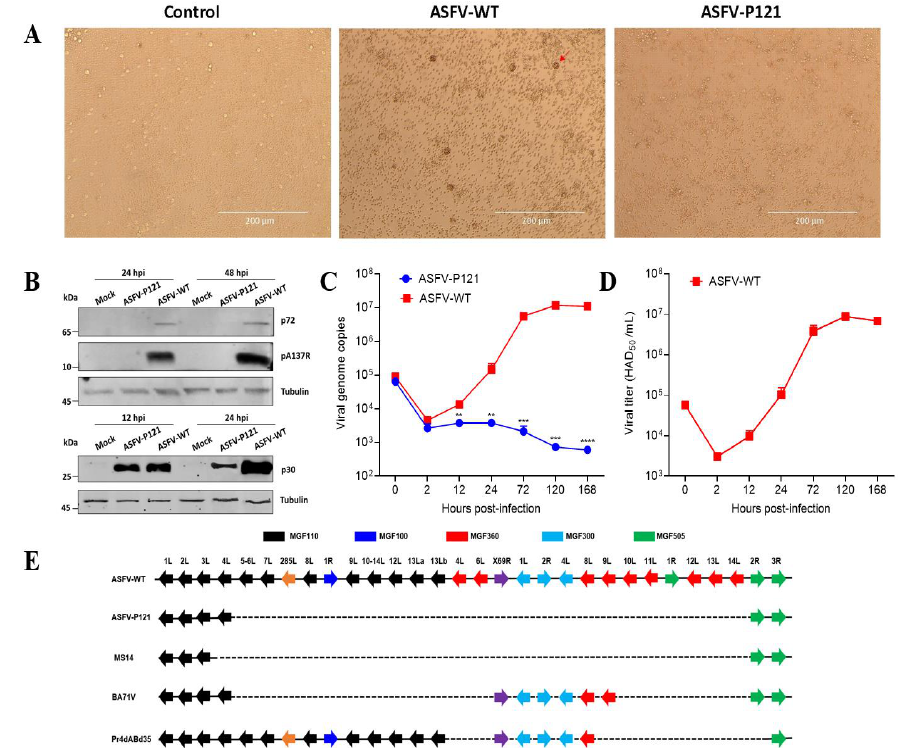
Figure 1. Cell-adapted ASFV lost the ability to replicate in PAMs. ( A ) Hemadsorption assay of PAMs infected with ASFV-P121 or ASFV-WT (MOI = 5). Pig erythrocytes were added to the ASFV- infected PAMs. The presence of rosettes was checked at 72 hpi (scale bars, 400 µm). The red arrow indicated a rosette of red blood cells. ( B ) Analysis of ASFV protein expression in PAMs. PAMs were infected with ASFV-P121 or ASFV-WT (MOI = 5), and the viral proteins were detected using the antibodies against the p72, A137R, and p30 proteins. ( C , D ) In vitro growth kinetics of ASFV-P121 or ASFV-WT in PAMs. PAMs were infected with ASFV-P121 or ASFV-WT (MOI = 0.01). The cell cul- tures were obtained at the indicated time points post-infection, and ASFV genome copies ( C ) and titers ( D ) were determined. The data are presented as the mean ± SD of three independent experi- ments. (** p < 0.01; *** p < 0.001; **** p < 0.0001). ( E ) Schematic representation of the MGF genes deletion observed at the left variable region in the genome of the cell-adapted ASFV mutants. Subsequently, we performed genome sequence alignment to screen the possible de- terminant of the cell-adapted ASFV strains (e.g., ASFV-P121, MS14, and BA71V) that can- not replicate in PAMs. We found that the most significant variation was the deletion of varying MGF genes in the LVR of the cell-adapted ASFV (Figure 1E). The LVR deletion in the ASFV-P121 genome is up to 24.5 kb, covering many MGF genes, including MGF110,